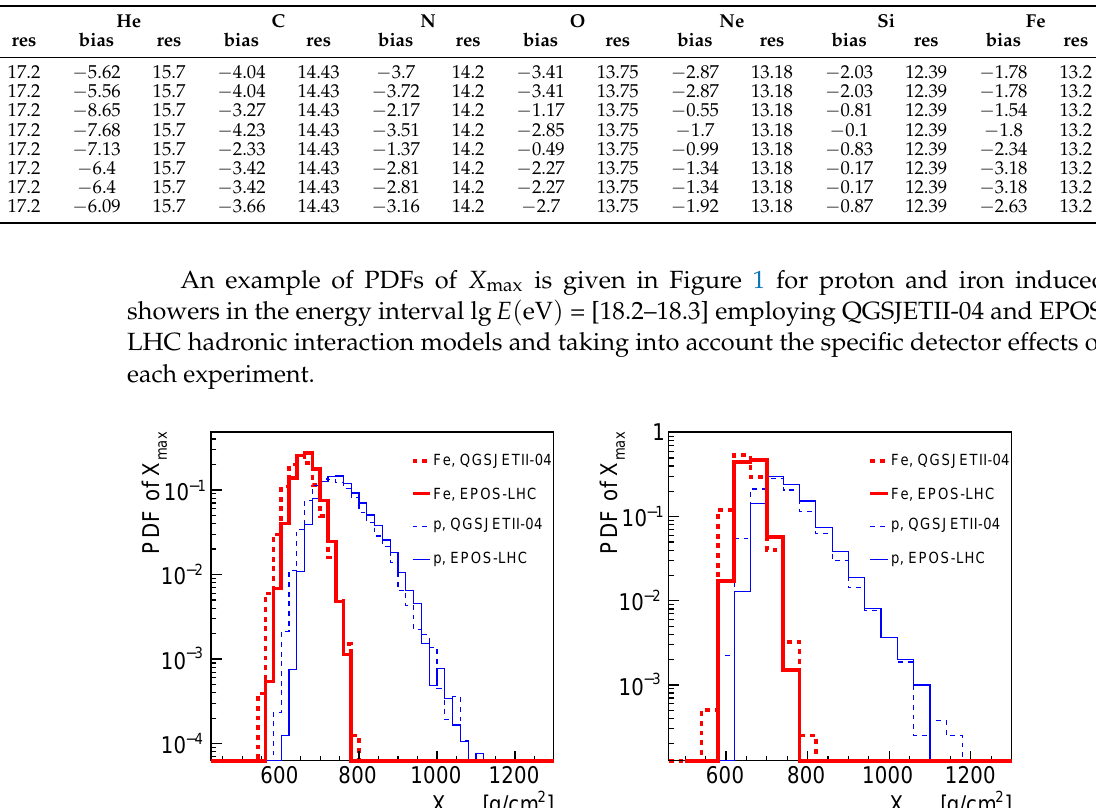
Table 1. The values of the biases and resolution in units of [g/cm 2 ] used to build MC templates for the case of TA data in each energy interval for eight primary species.